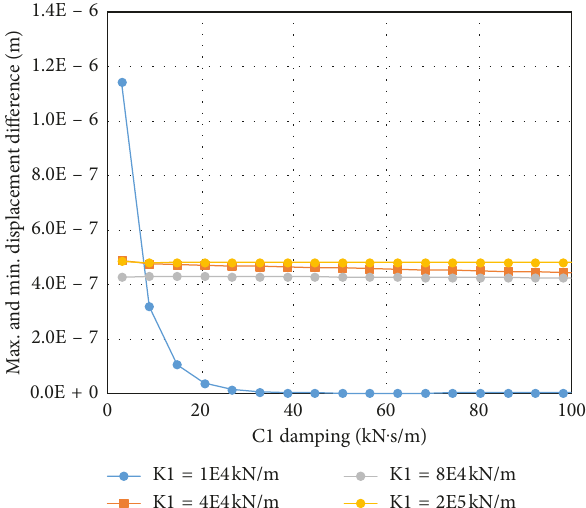
Figure 1: The slab vibration changing with the rail stiffness ( K and damping ( C 1 ) using the two-degrees-of-freedom model.